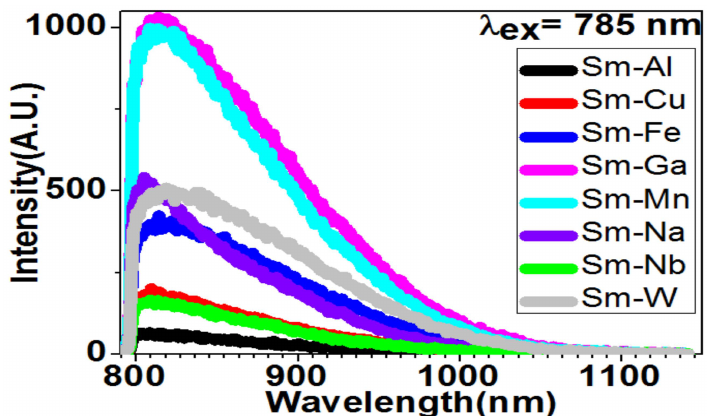
Figure 6. Near-infrared fluorescence for Sm–Me (Me = Fe, Ga, Mn, Na, Nb, W, Cu, and Al) nanoparticles can be generated by 785 nm excitation light.